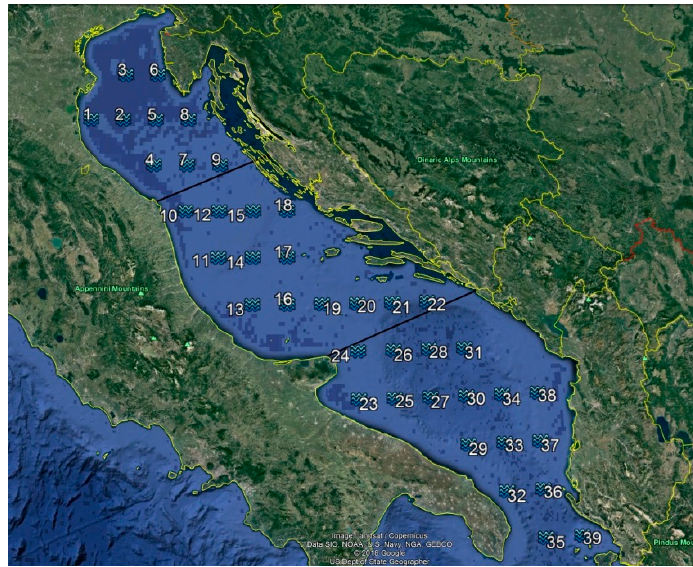
Figure 1. Studied locations in the Adriatic Sea as available from the WW database. At each location, 12 physical wave and wind parameters are available at 6-h intervals (four per day) as presented in Appendix A Table A2 and for each location there are total of 34,460 lines of records.